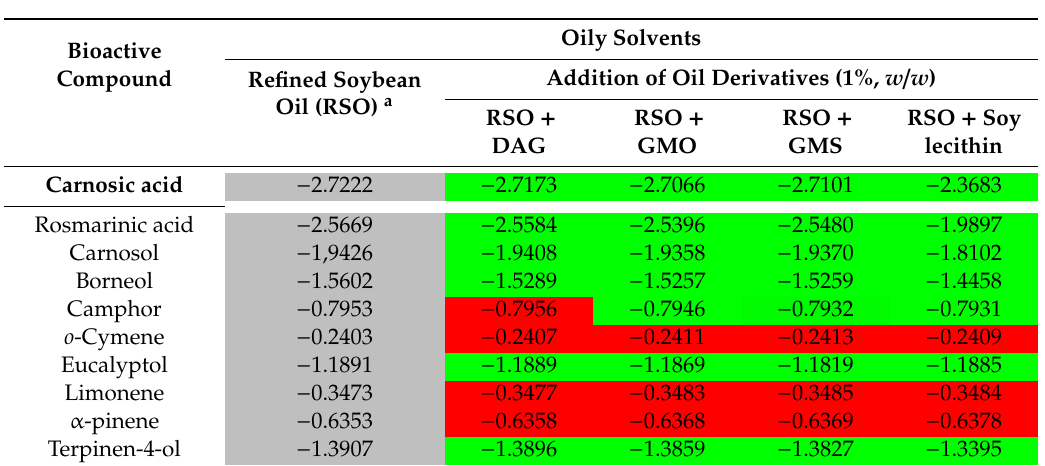
Table 2. Relative solubility of non-volatile and volatile bioactive compounds in refined soybean oil and its mixture with oil derivatives using the COSMO-RS